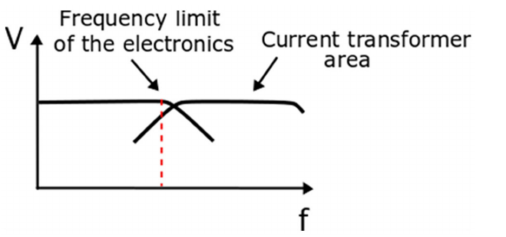
Figure 3. Frequency characteristics of the transducer and inductive current transformer.